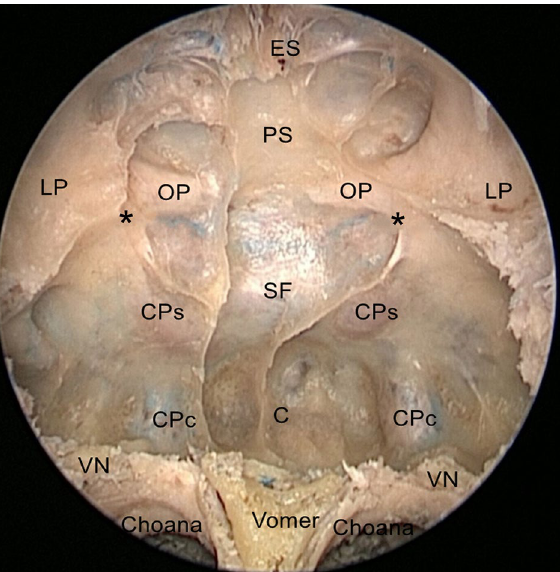
Figure 2. Endoscopic view of the sphenoidal sinus posterior, lateral walls, key anatomical bony landmarks were identified after complete posterior ethmoidectomy, and sphenoidotomy. PS Planum sphenoidale, OP optic prominence, CPs parasellar segment of the carotid prominence, CPc paraclival segment of the carotid prominence, SF sellar floor, C clivus, LP lamina papyracea, ES ethmoid sinus, VN vidian nerve. *Opticocarotid